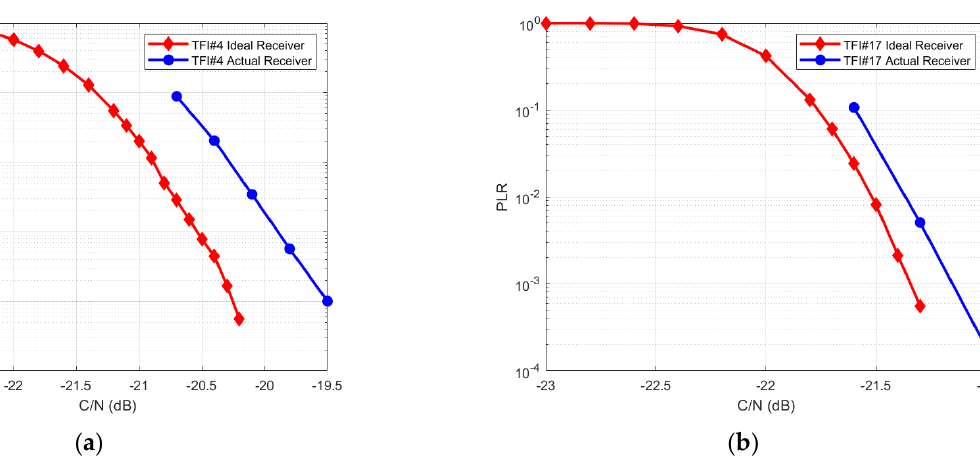
Figure 12. Implementation loss less than 1 dB at PLR= 10 (cid:2879)(cid:2871) for TFI#4; (b) Implementation loss less than 1 dB at PLR = 10 (cid:2879)(cid:2871) for TFI#17